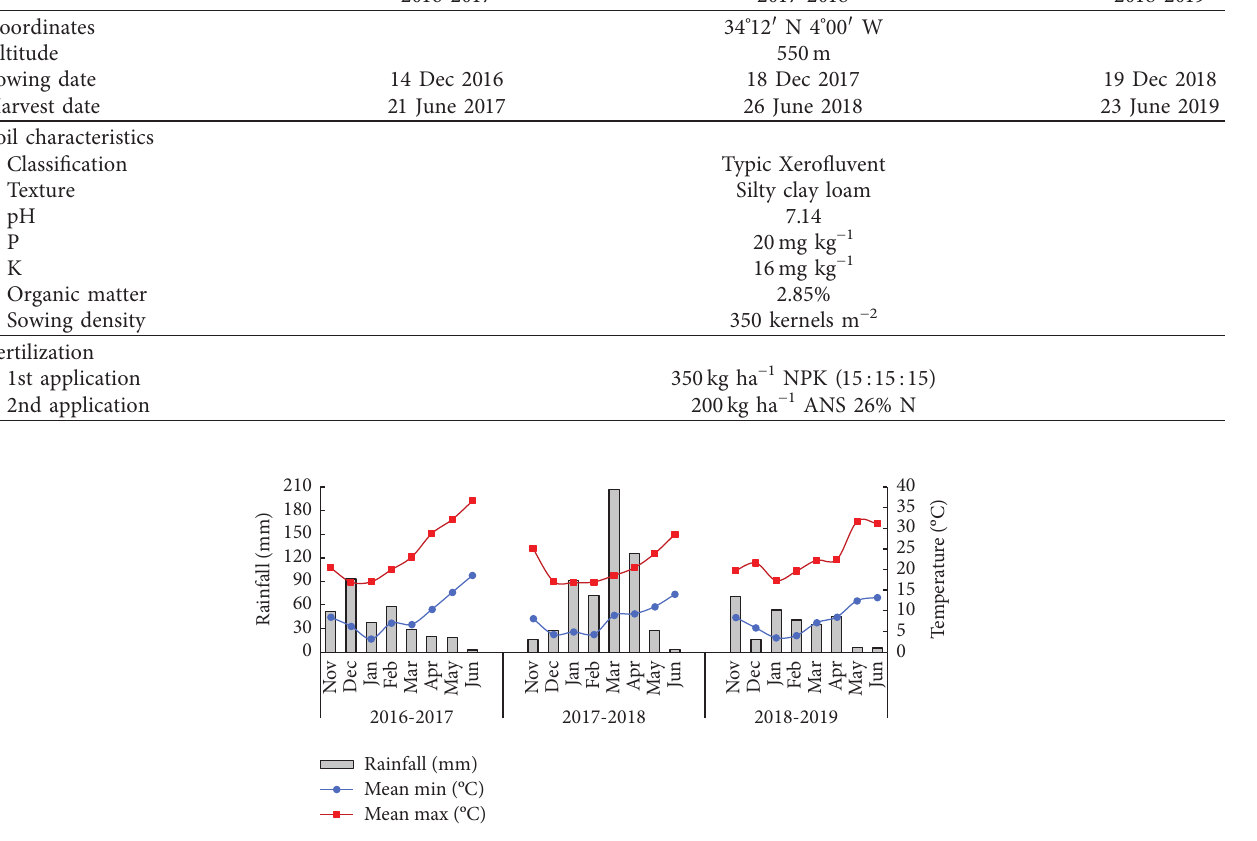
Figure 1: Rainfall distribution and average air temperatures during 2017, 2018, and 2019. Table 2: Year of release and pedigree of six durum wheat varieties used in the current study.